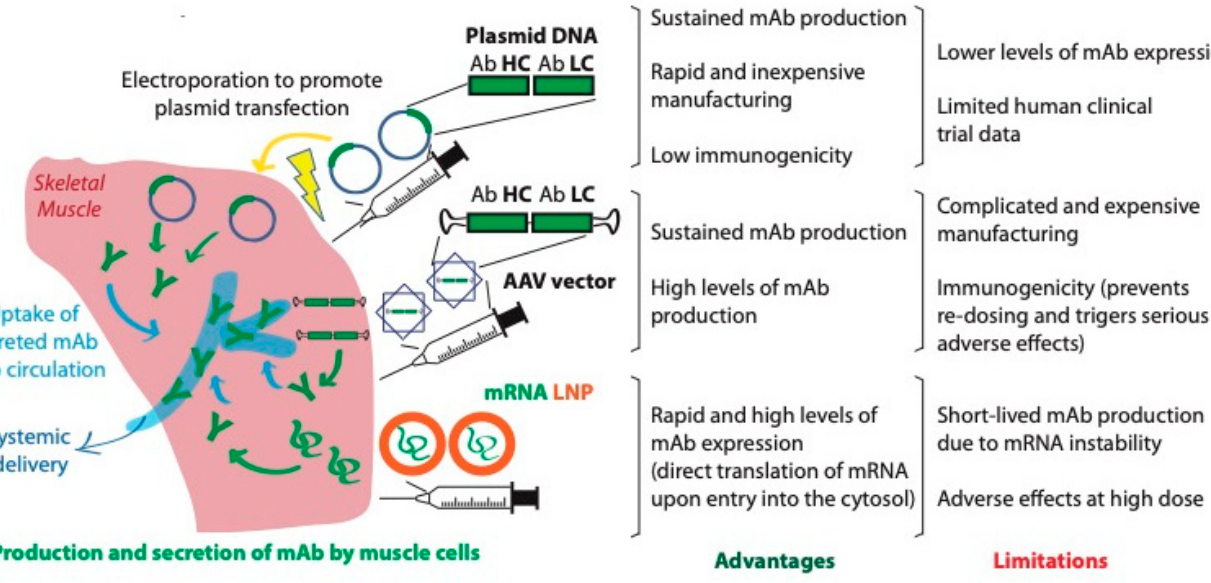
Figure 1. Comparison of various approaches to nucleic acid-based delivery for in vivo production of mAbs, including viral (AAV) and non-viral (electroporation of pDNA and lipid nanoparticle formulated mRNA).